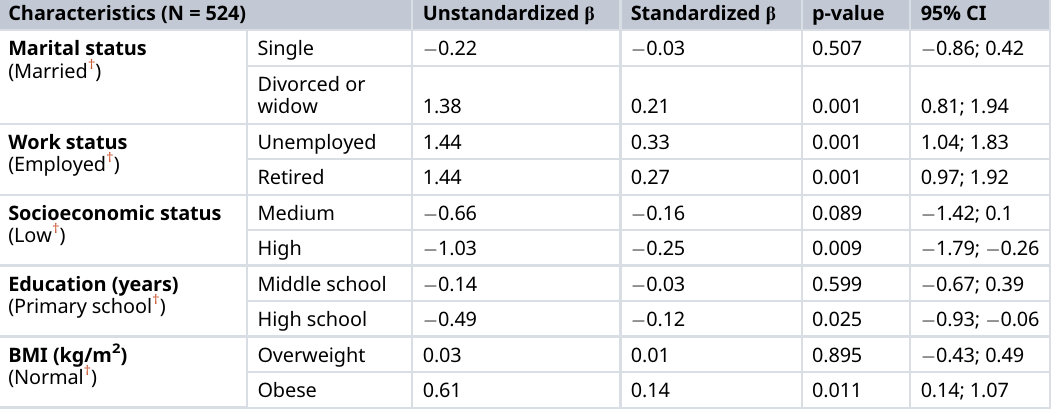
Table 3. Multivariable analysis: linear regression taking the CHA 2 DS 2 -VASC score as the dependent variable. Characteristics (N =